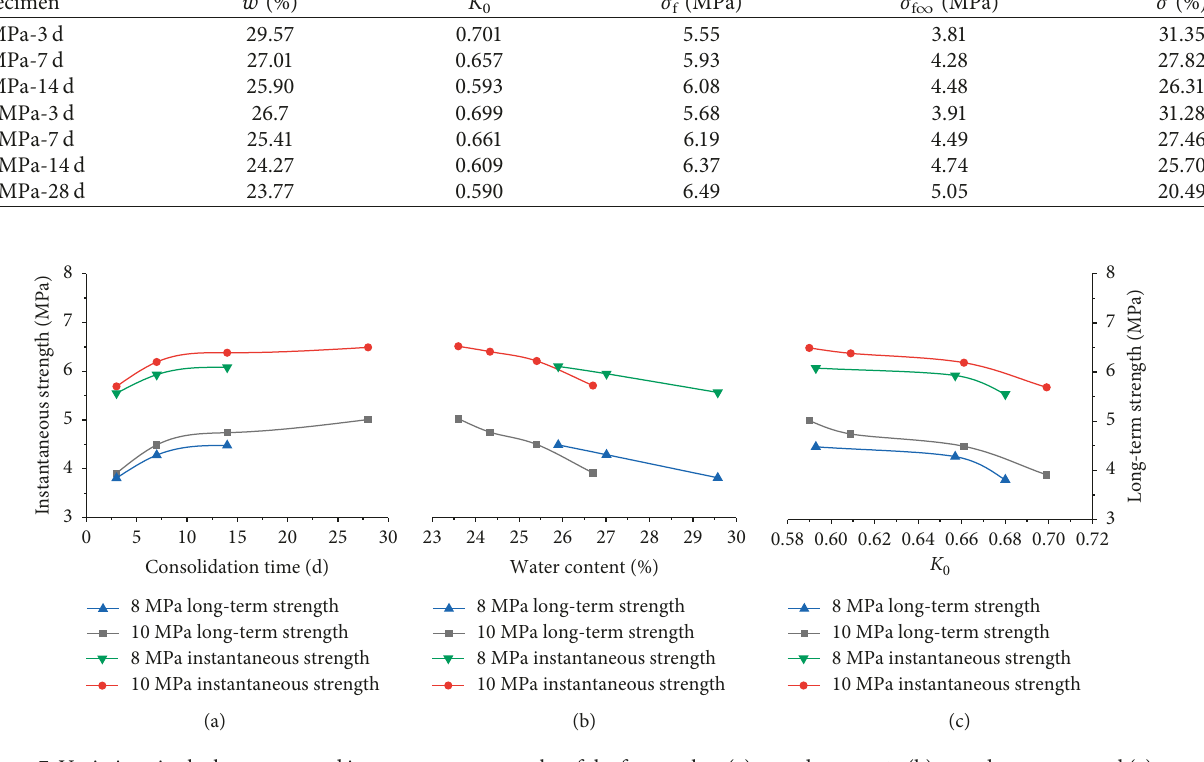
f and σ f ∞ vs. t c , (b) σ